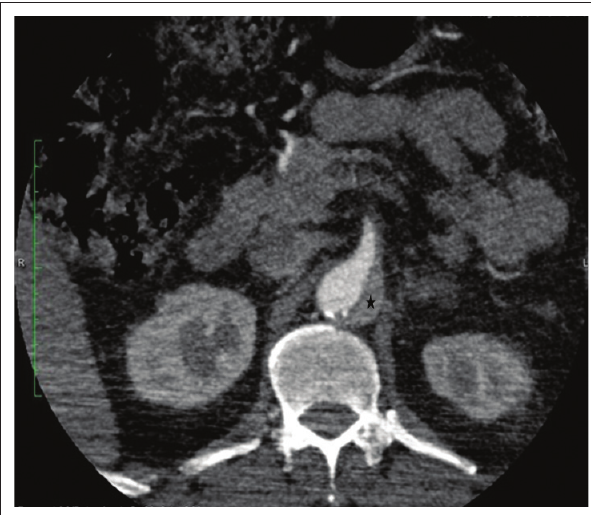
FIGURE 4: Stanford type B dissection with extension into the superior mesenteric artery. Contrast-enhanced computed tomography showing lesser enhancement in the false lumen ( * ) as compared to true lumen.